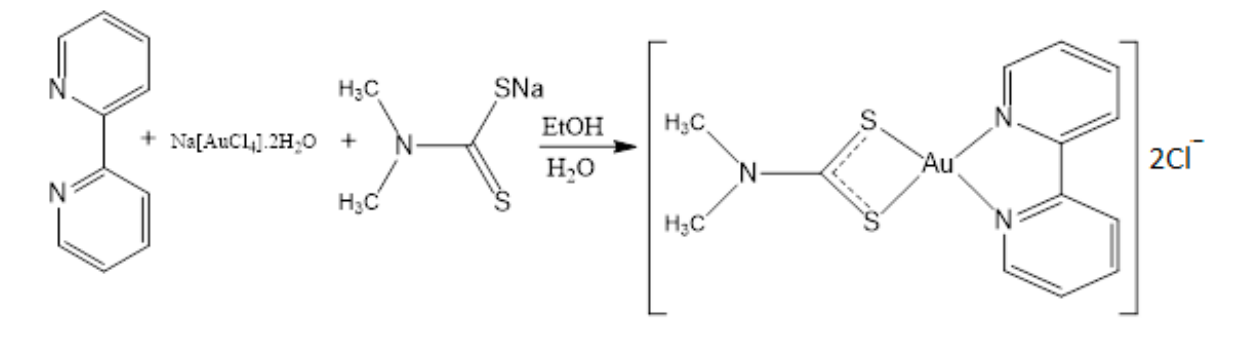
Figure 2. The synthesis of Complex ( 1